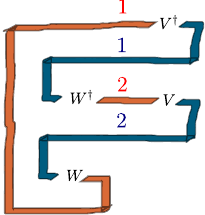
FIG. 3. Interpretation of Eq. (13) in terms of local states. ˆ W ˆ V † ˆ W † ˆ V (a) Notation of the five different “ particle types ” that can occur: ð t Þ i , as a ð t Þ the first four correspond to exactly two of the four layers (shown in Fig. 2) being occupied by a charge, while the last one is a bound state, formed by either the first two or the second two particle types. The empty state is not denoted. (b) Some possible one- and two-particle processes generated by averaging over a single two-site